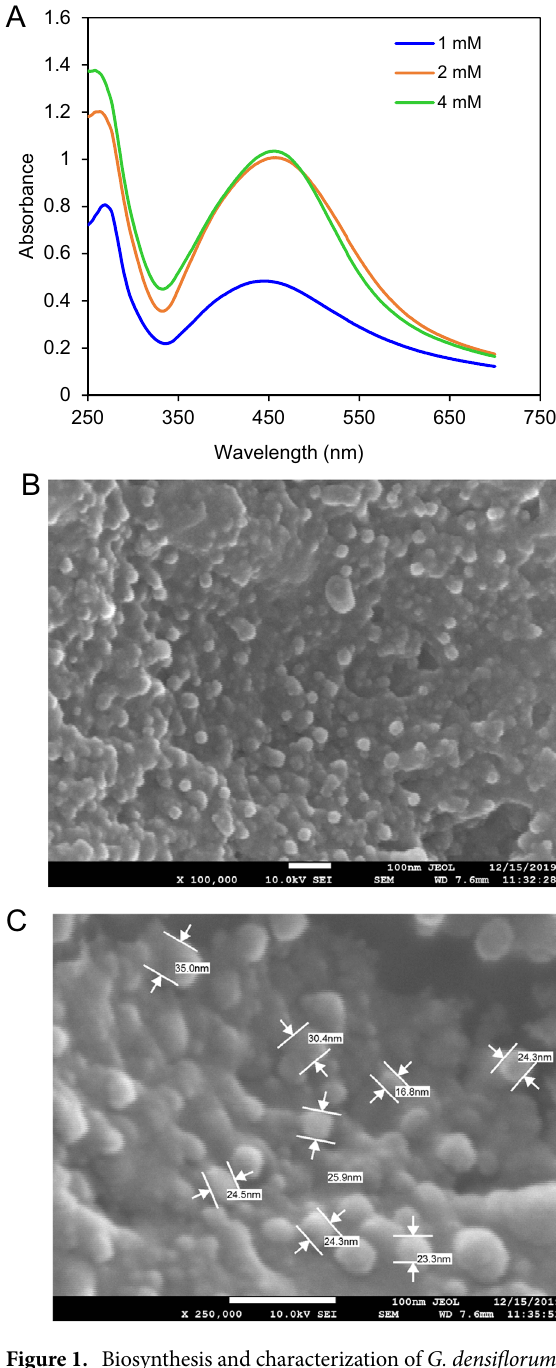
Figure 1. Biosynthesis and characterization of G. densiflorum -Ag/AgCl-NPs ( A ) UV–visible spectra indicating synthesis of nanoparticles after mixing different concentrations of AgNO 3 with the rhizome extract. ( B ) SEM micrograph of the synthesized nanoparticles. ( C ) Morphology and size of the